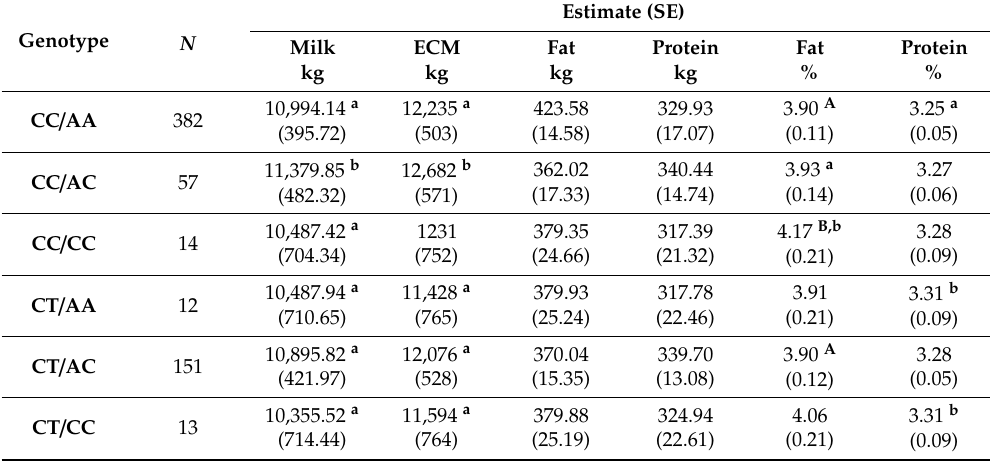
Table 2. The estimates and their standard errors (SE) of the e ff ects of defensin genotypes for the investigated traits during the whole